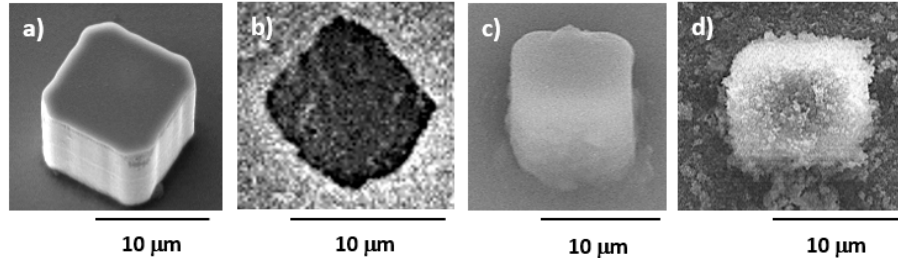
Figure 2. SEM micrographs of micro-post replication: ( a ) micro-post on a silicon wafer, ( b ) copied micro-post by using liquid PDMS, ( c ) replicated micro-post by using the copied micro-post and liquid PDMS, ( d ) functionalized silica particles deposited on replicated micro ‐ post.